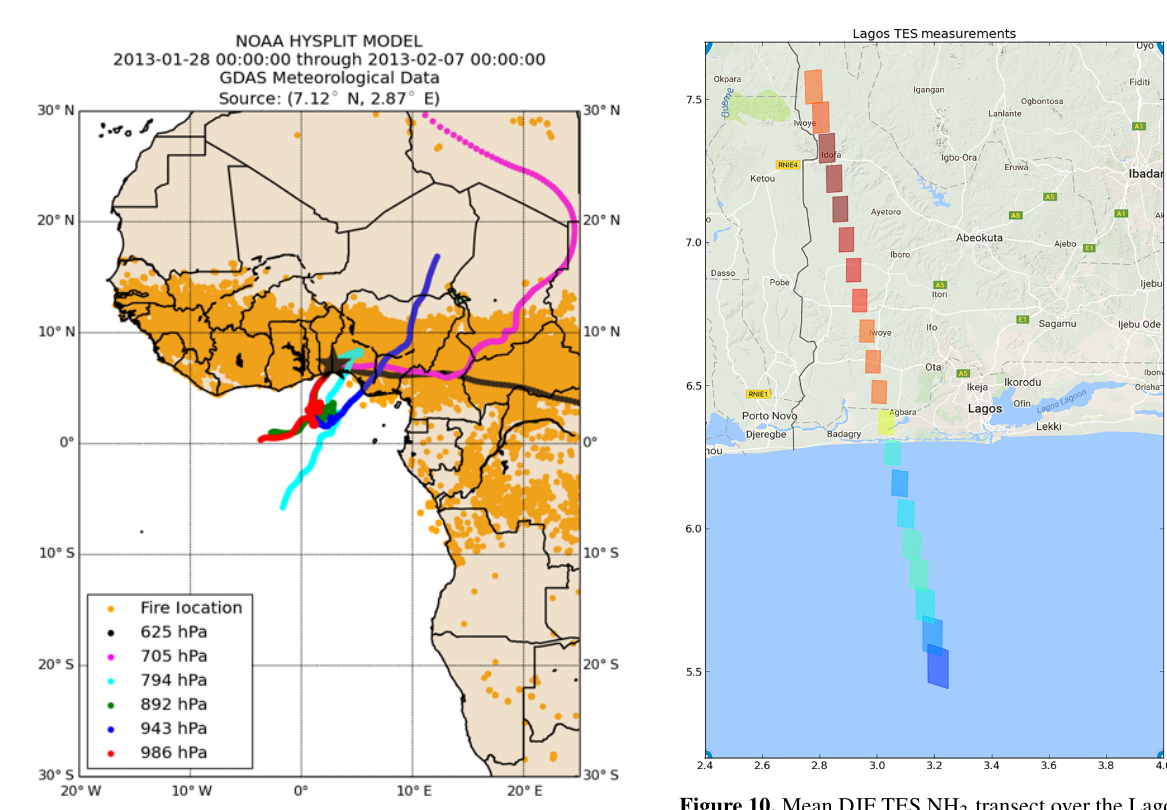
Figure 9. HYSPLIT back trajectories and FIRMS fire locations over western Africa for 7 February 2013. Fire map include fires from 7 February and the previous 10 days.